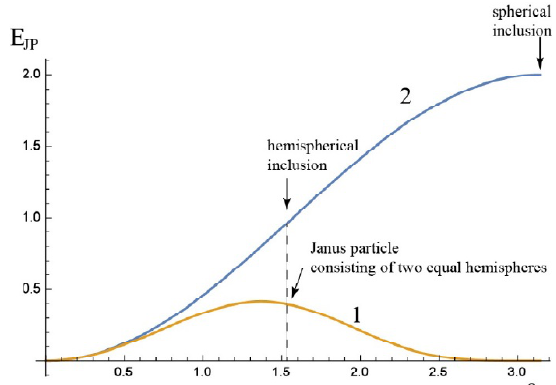
Fig. 7. Map of the elastic dilatation in the JP, con- sisting of two equal hemispheres with equatorial position ( z =0) of the interface. The dilatation values are given in units of the eigenstrain  *, which is at- tributed to the upper hemisphere. The map coordi- nates are normalized to the JP radius a . The calcu- lations are made for the material with  =0.3.